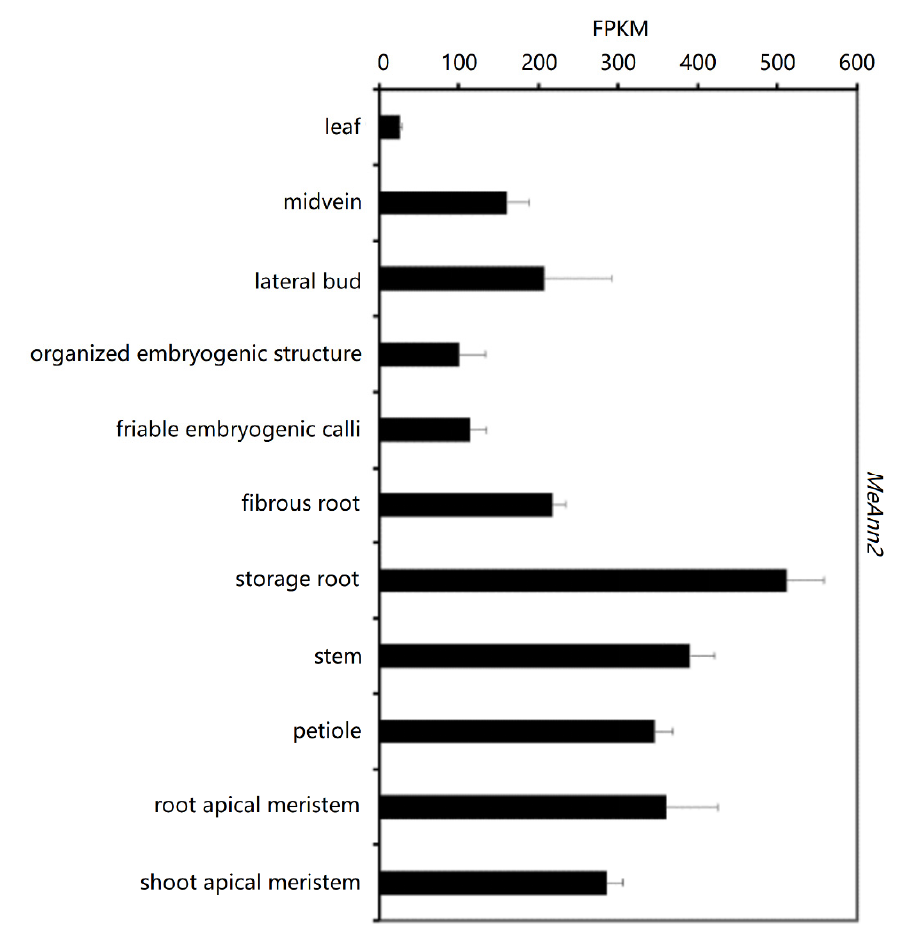
Figure 3. Analysis of MeAnn2 gene expression in different organs or tissues. Error bars indicate ± SD.